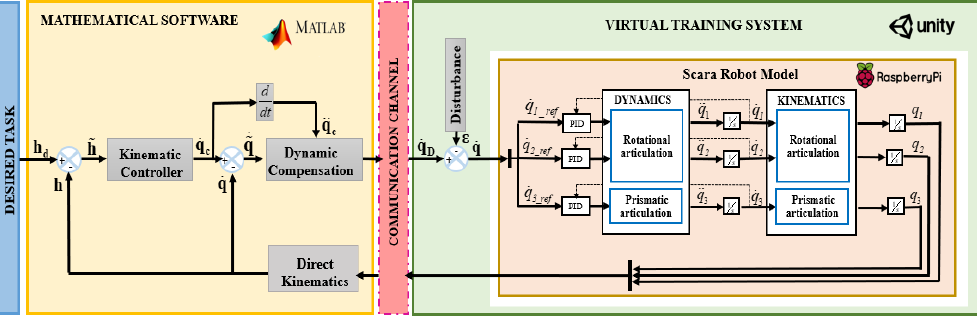
Figure 7. Proposed control scheme.